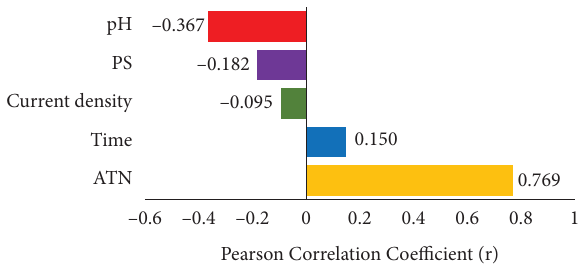
Figure 6: Sensitivity analysis using the Pearson correlation.